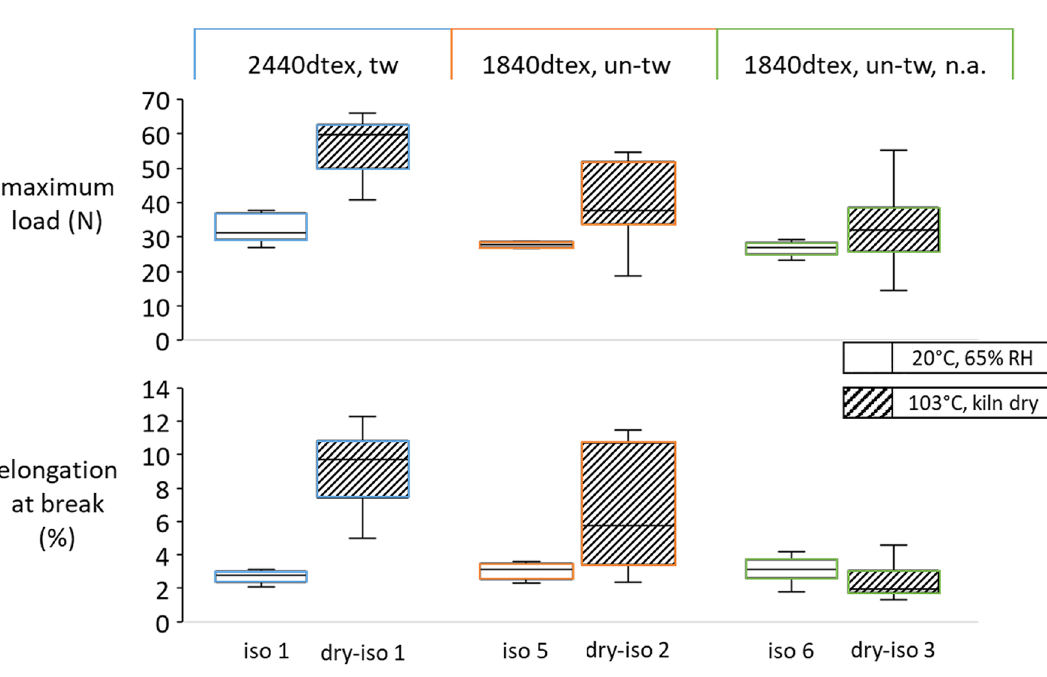
Figure 9. Tensile properties of twisted (tw) and untwisted (un-tw) yarns with and without (n.a.) avivage, respectively, conditioned at 20 °C, 65% RH or kiln dried at 103 °C prior to impregnation with isocyanate